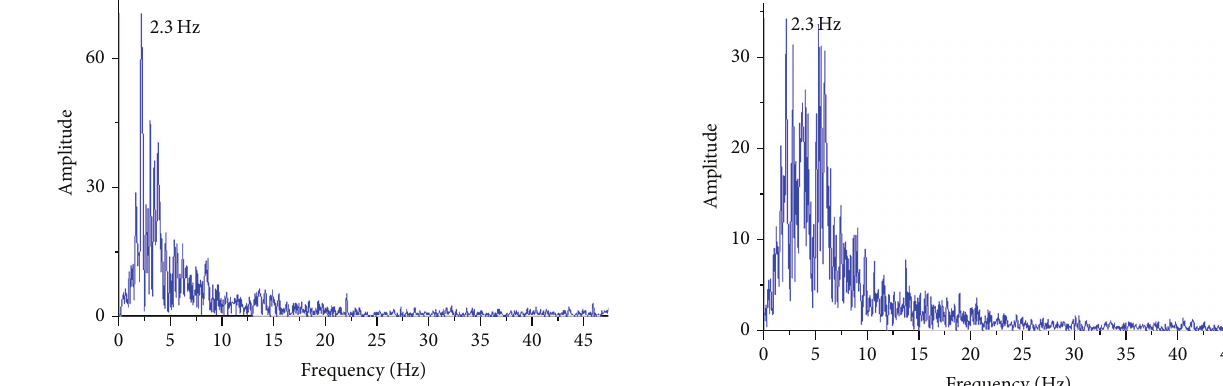
Figure 12: The FFT of Wolong ground motion in 𝑌 direction.